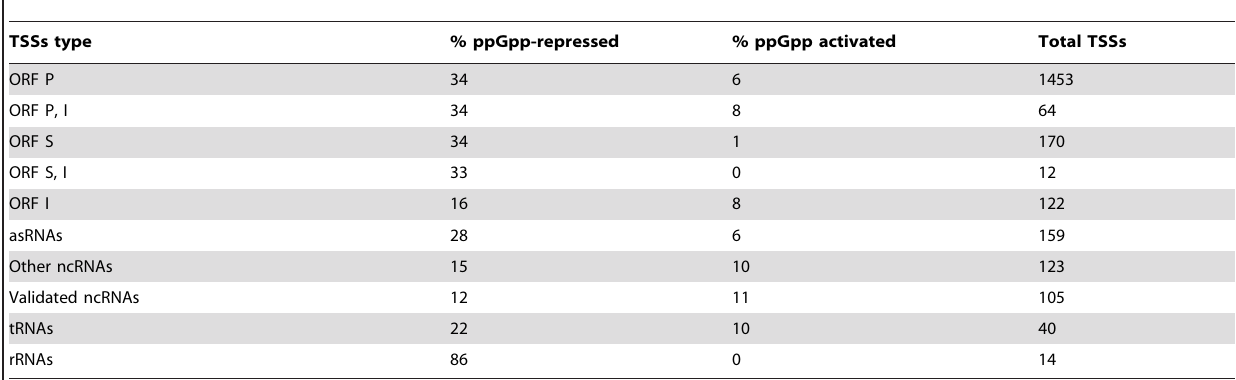
Table 1. The relative proportions of ppGpp-repressed and ppGpp-activated TSSs within the S . Typhimurium genome at LSP.